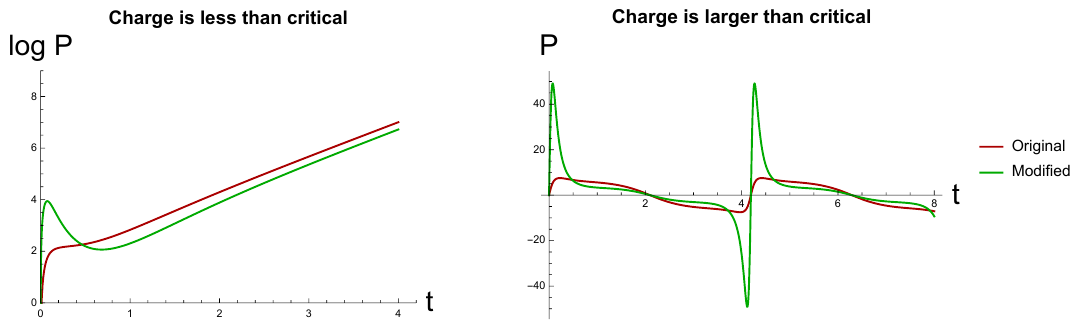
Figure 4 . The momentum time dependence for di(cid:11)erent charge values and (cid:22) = 1 : 3, d = 3, z h = 1, z (cid:3) = 0 : 1. The left plot corresponds to the charge value q = 4 (less than the critical one). The right plot corresponds to the charge q = 9 (larger than the critical one). Red curves on both plots correspond to the duality without the inclusion of the energy scale. The green curves correspond to the modi(cid:12)ed